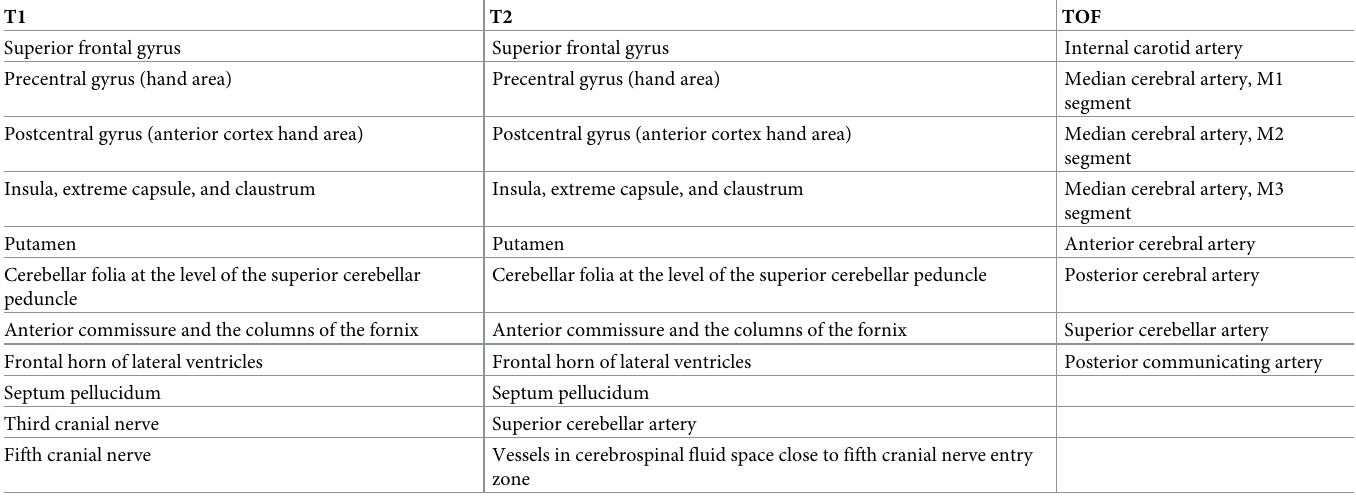
Table 2. Anatomical structures evaluated in image quality assessment for the different